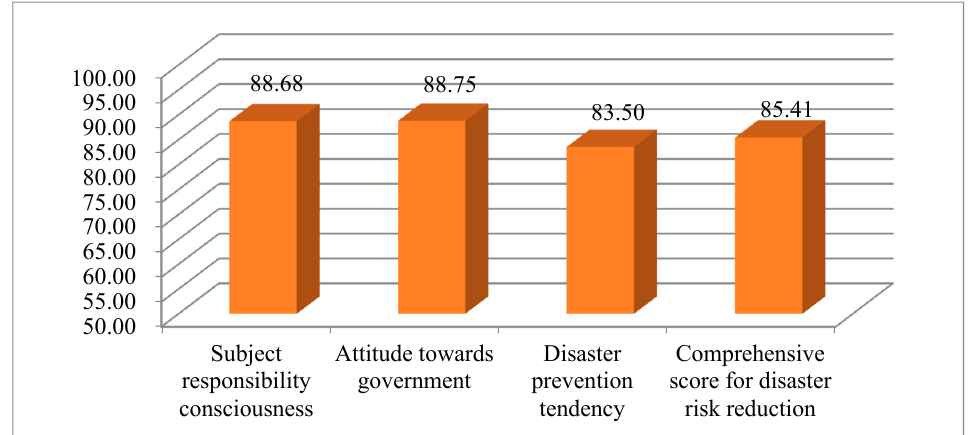
Figure 4. The scores of rural households’ awareness of disaster risk reduction.